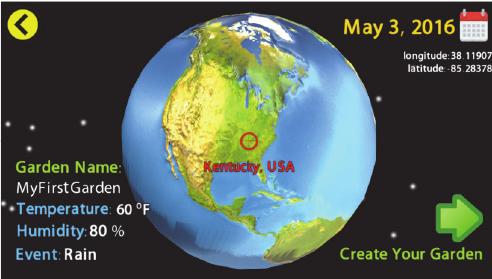
Figure 10: Select-location scene in Little